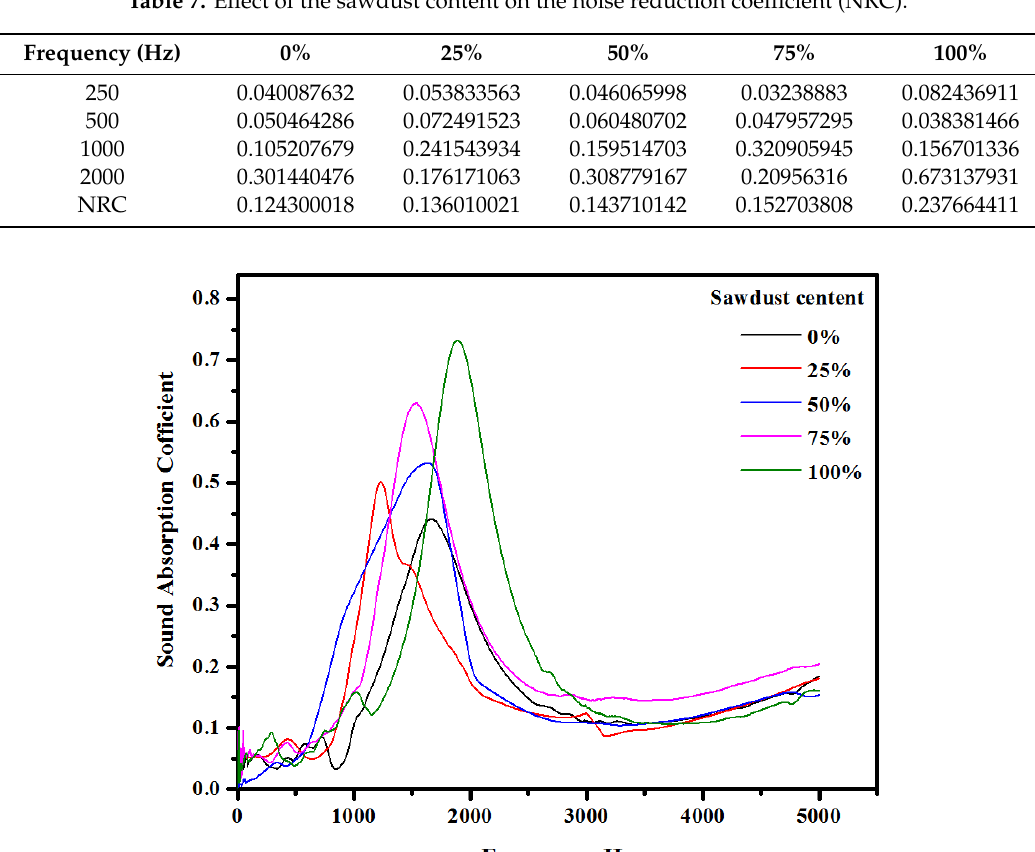
Figure 17. Sound absorption coefficients of the concretes prepared with different amounts of sawdust wastes.